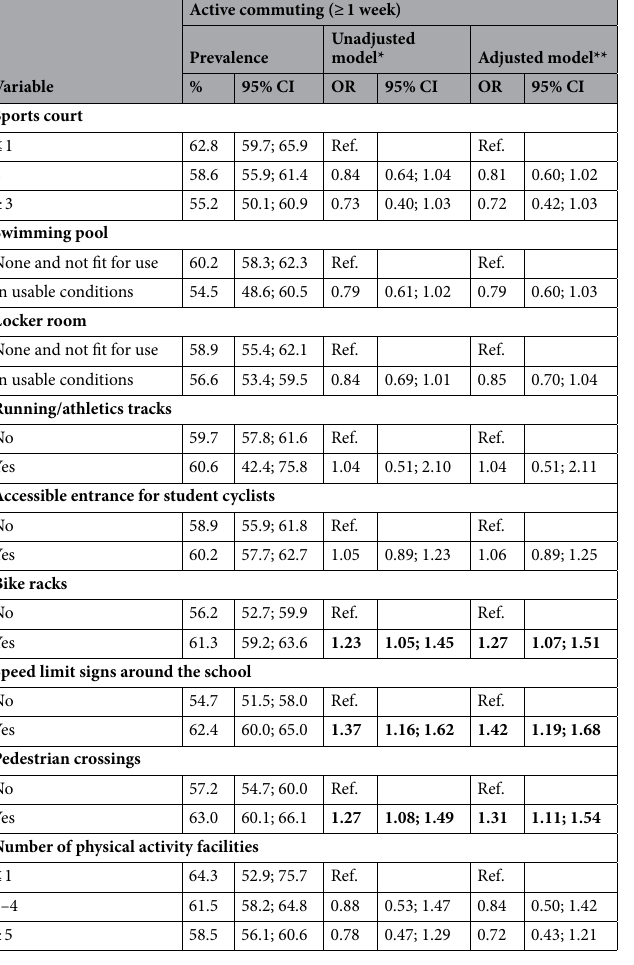
Table 6. Association between school characteristics and active commuting to/from school in adolescents. Values in bold indicate significant associations; 95% CI 95% confidence intervals, OR odds ratio. *Number of adolescents enrolled in the school as first level and type of school as second level. **Number of adolescents enrolled in the school as first level, type of school as second level, adjusted by sex, age (years), skin color/ ethnicity, and mother’s employment